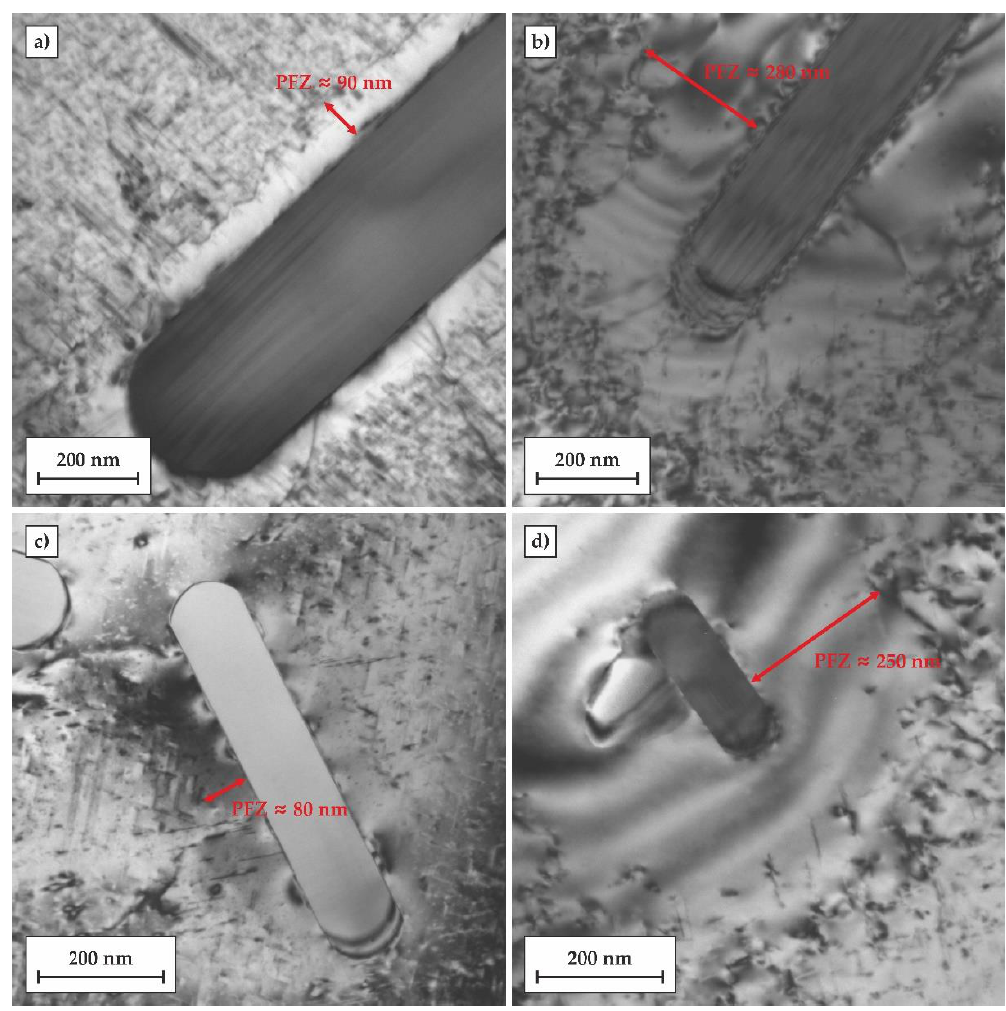
Figure 10. TEM micrographs showing second phase particle regions of the alloy after two investigated heat treatments: ( a , c ) conventional heat treatment to the T6 temper including artificial ageing at 170 °C for 24 h; ( b , d ) quenched directly to the temperature of 170 °C followed by 24 h of artificial ageing (T6DA).